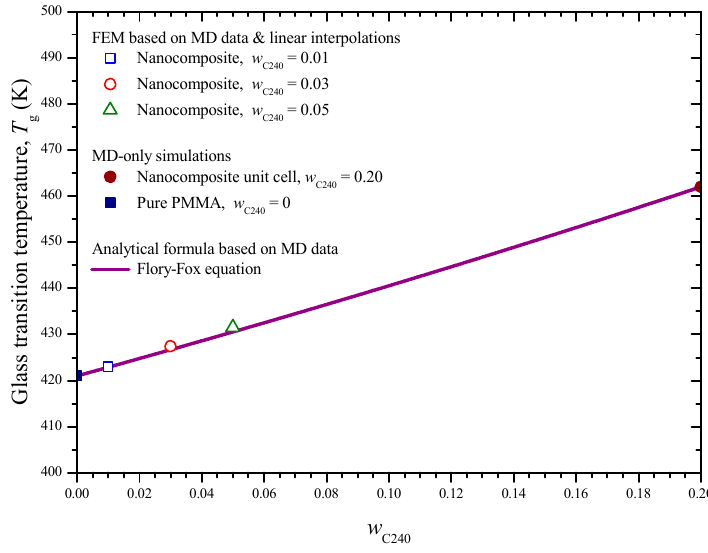
Figure 15. Glass transition temperature of the nanocomposite for small fullerene mass fractions, predicted by combining FEM and MD as well as using linear interpolations.